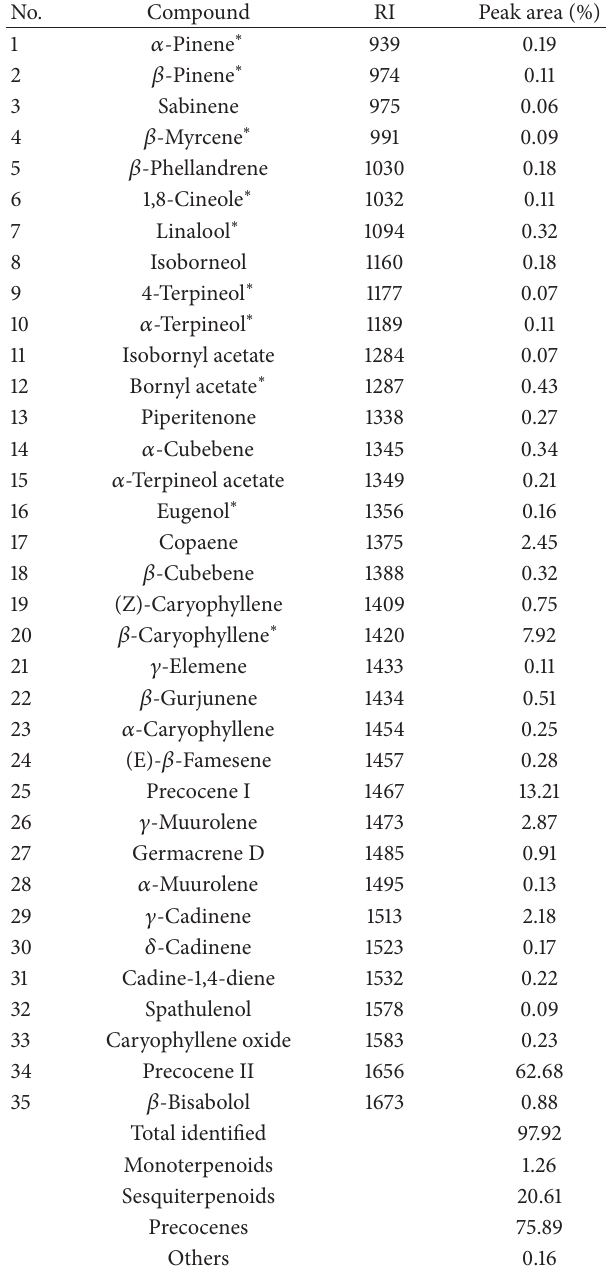
Table 1: The scale to be assign repellency of the essential oil and its constituents.